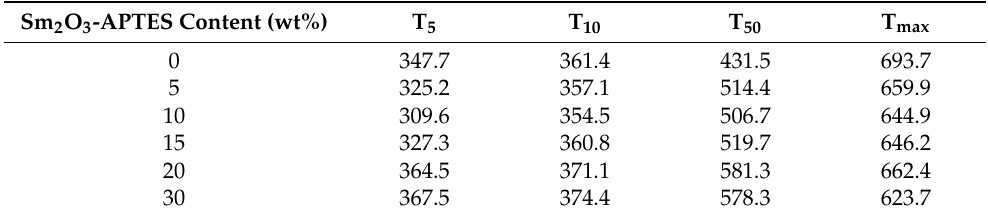
Figure 8. Thermal performance curves: ( a ) TG; ( b ) DTG; ( c ) DSC and ( d ) T g of Sm 2 O 3 -APTES/AFG-90H. Table 2. TG data for Sm 2 O 3 -APTES/AFG-90H ( ℃ ).